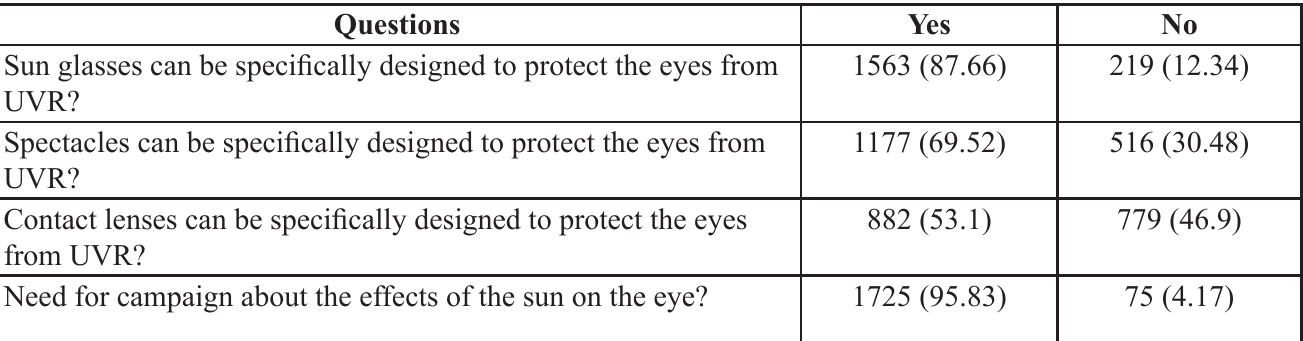
Table 3: Shows the percentages of the total participants who responded to the questions as stated. Many knew that sunglasses and spectacles can be specifically designed to block UV radiation.